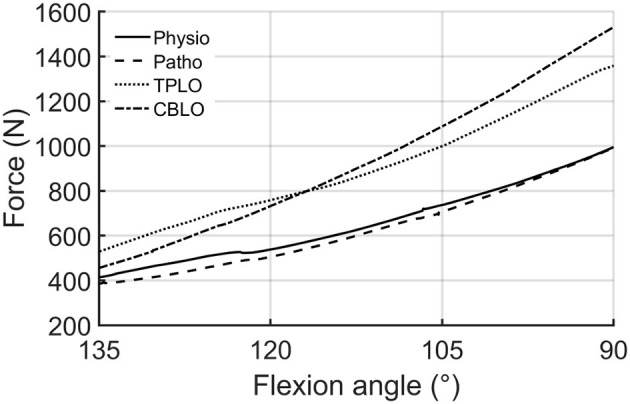
Compressive force representing the intra-articular contact force directed perpendicular to the tibial plateau measured during the squat simulation.